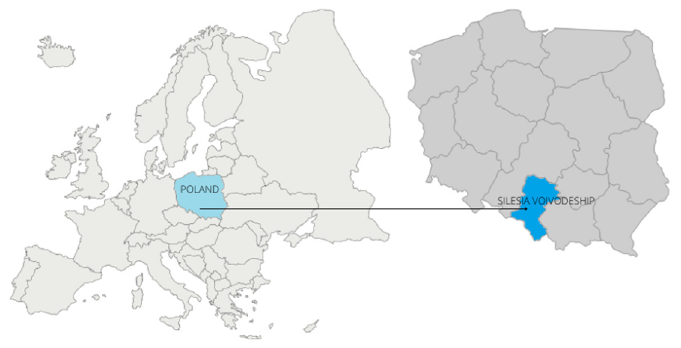
Figure 1 . The place of the survey. Figure 1. The place of the